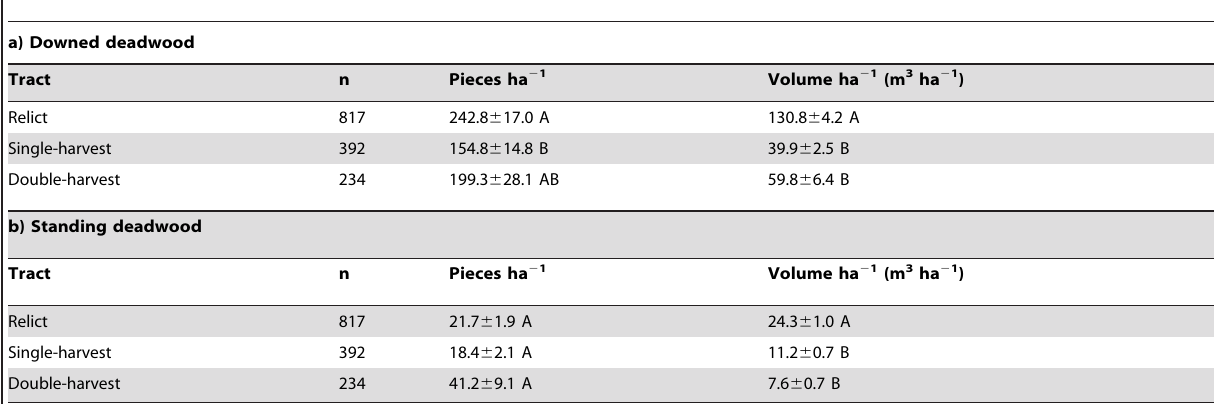
Table 2. Coarse woody debris stand-level